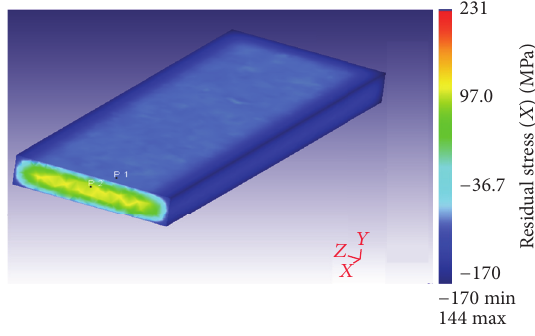
Figure 4: Results of residual stress ( 𝑋 ) after quenching.